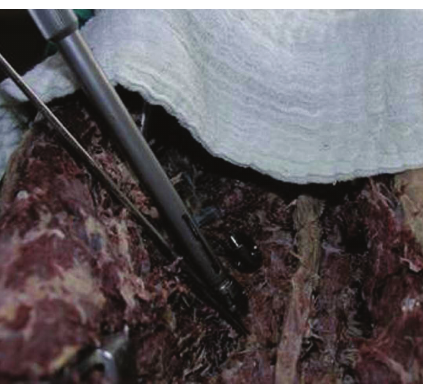
Figure 4: The 10-degree screw is inserted. The change in angle is seen after resistance and change of the trajectory.